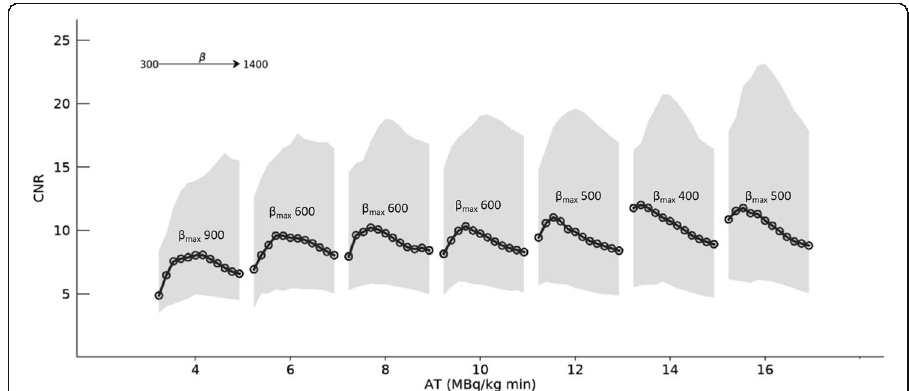
Fig. 2 Contrast-to-noise ratio measured in pathological lesions. The median value (solid black line with circles) and 25th – 75th percentile ranges (shaded grey area) are shown. The highest CNR for each AT is obtained at β max , shown in the figure